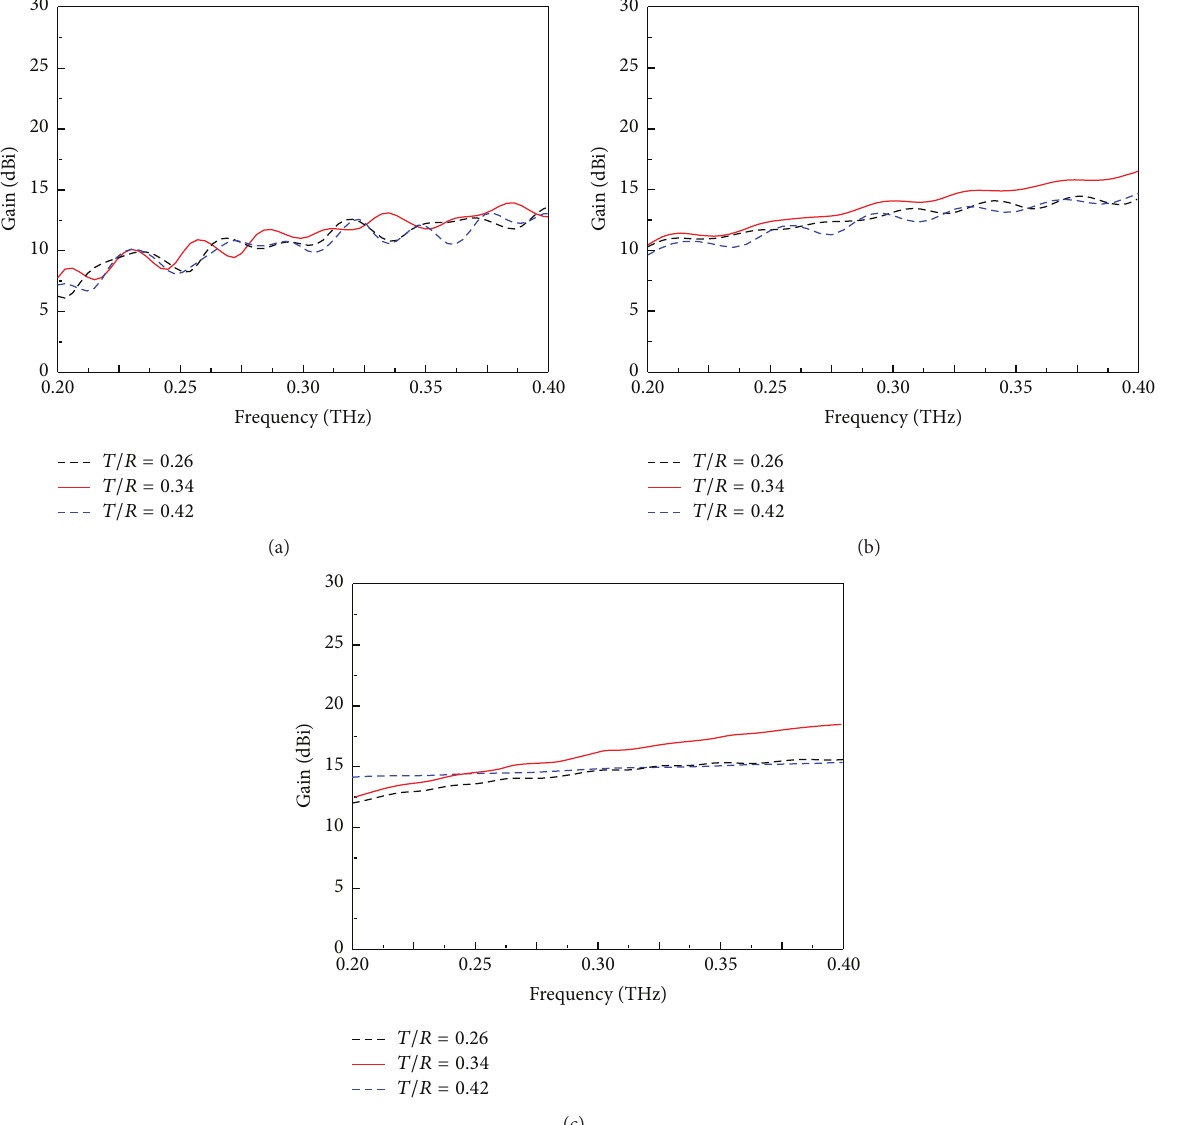
Figure 2: Comparison plots of antenna gain for different 𝑇/𝑅 values with (a) 𝑅 = 0.8 𝜆 𝑜 , (b) 𝑅 = 1.2 𝜆 𝑜 , and (c) 𝑅 = 1.6 𝜆 𝑜 compared to